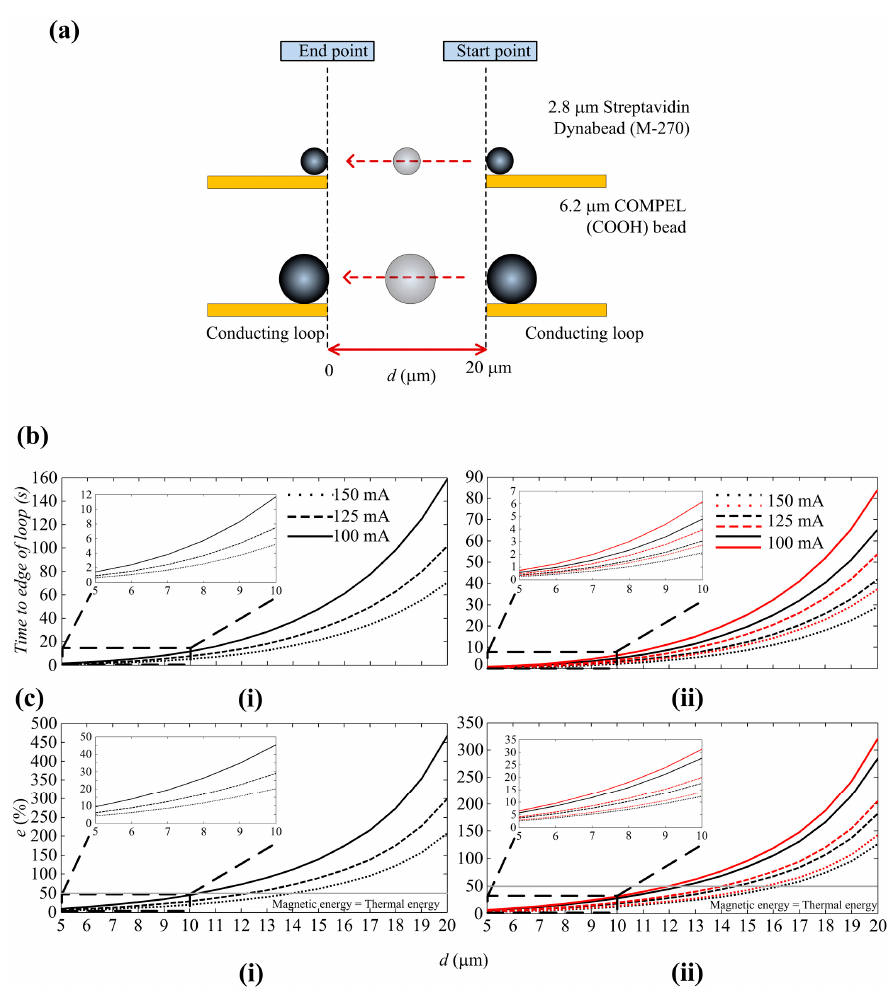
Figure 4. ( a ) Travel path of the SPBs; ( b ) The time taken for (i) COMPEL™ bead and (ii) Dynabead ® (black lines) and polystyrene YG particle tagged with a Dynabead ® (red lines) to travel to the edge of a loop, from a maximum distance of 20 μ m from the edge; ( c ) Error caused by diffusion for (i) COMPEL™ bead and (ii) Dynabead ® and polystyrene YG particle tagged with a Dynabead ® .